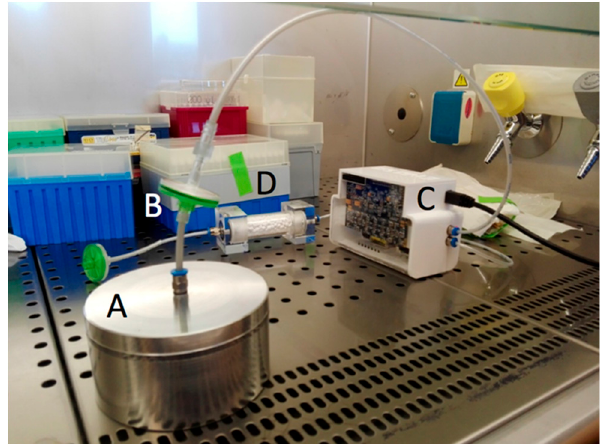
Figure 1. Picture showing the experimental system set-up under a biohazard hood. ( A ) Petri dish covered with customized lid suitable to ensure a stable headspace; ( B ) filter used to block spore migration from Aspergillus culture to sensors; ( C ) the electronic nose; ( D ) the CaCl 2 trap.